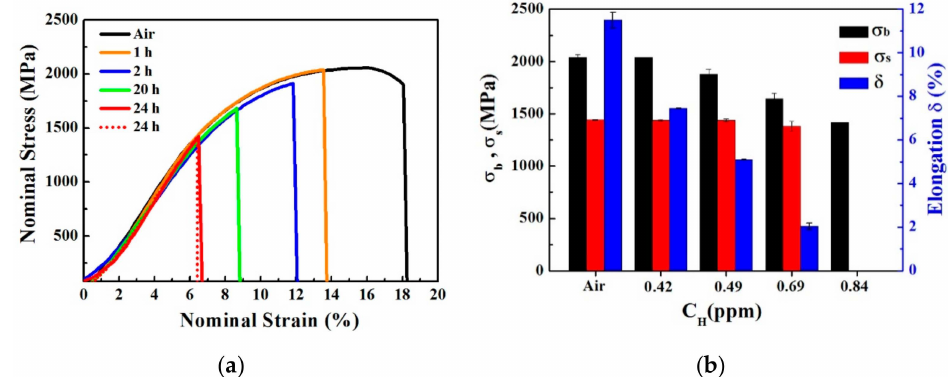
Figure 6. ( a ) The nominal stress-nominal strain curves with varying hydrogen pre-charge times, performed at two strain rates (solid curves represent a strain rate of 1 × 10 − 3 s − 1 ; the dotted curve represents a strain rate of 1 × 10 − 6 s − 1 ); and, ( b ) Ultimate tensile strength σ b , yield strength σ s, and elongation δ of the steel with di ff erent hydrogen content at a strain rate of 1 × 10 − 3 s − 1 .